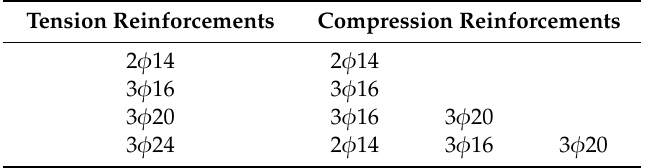
Table 1. Compression and tension reinforcement in the formed beam.